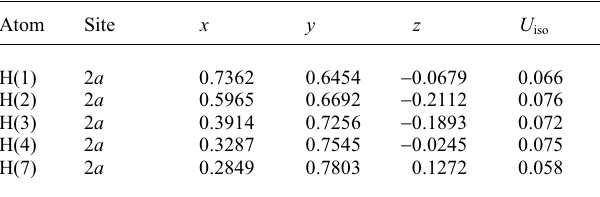
Table 2. Atomic coordinates and displacement parameters (in Å 2 )